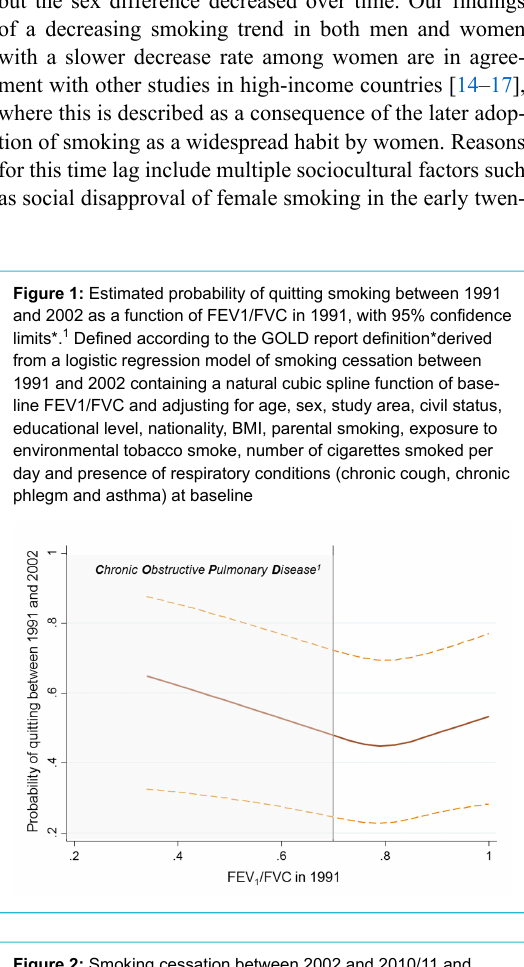
Figure 2: Smoking cessation between 2002 and 2010/11 and quality of life in 2002.SF36 index categories: low <25, medium ≥25/<75, high ≥75.Odds ratios of smoking cessation between SAPALDIA2 (2002) and SAPALDIA3 (2010/11) associated with SF36-scores of “social functioning” and “energy and vitality” are adjusted for age, sex, study area, civil status, educational level, nationality, BMI, exposure to environmental tobacco smoke, num- ber of cigarettes smoked per day, alcohol consumption, physical activity, new dog ownership, presence of chronic cough, chronic phlegm and asthma, depression, diabetes, cardiovascular disease, cancer and pulmonary function. There was no evidence of any as- sociation between smoking cessation and the other